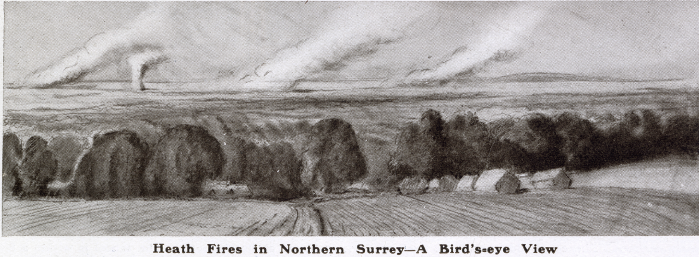
Figure A8. Photograph from the British illustrated newspaper The Sphere , 3 September 1921. The original caption is “Heath Fires in Northern Surrey – A Bird’s-eye View. This drawing was made on the North Downs. The panorama stretched away towards Aldershot on the west and St. George’s Hill on the east. Frequently six or seven fires could be seen burning together at one time. Suddenly smoke would shoot upwards like a pillar, and then, meeting a current of air, it would drift away to the east”. Copyright: Illustrated London News Ltd/Mary Evans.